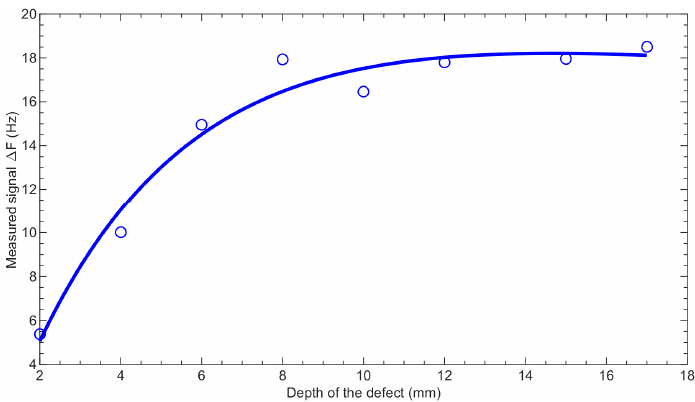
Figure 11 . Maximum values of the deviation of the fundamental frequency measured for the aluminum samples with defects having different depths (solid line—approximation curve, circles—exact measured values).